Question: In one sentence, what is this figure communicating?
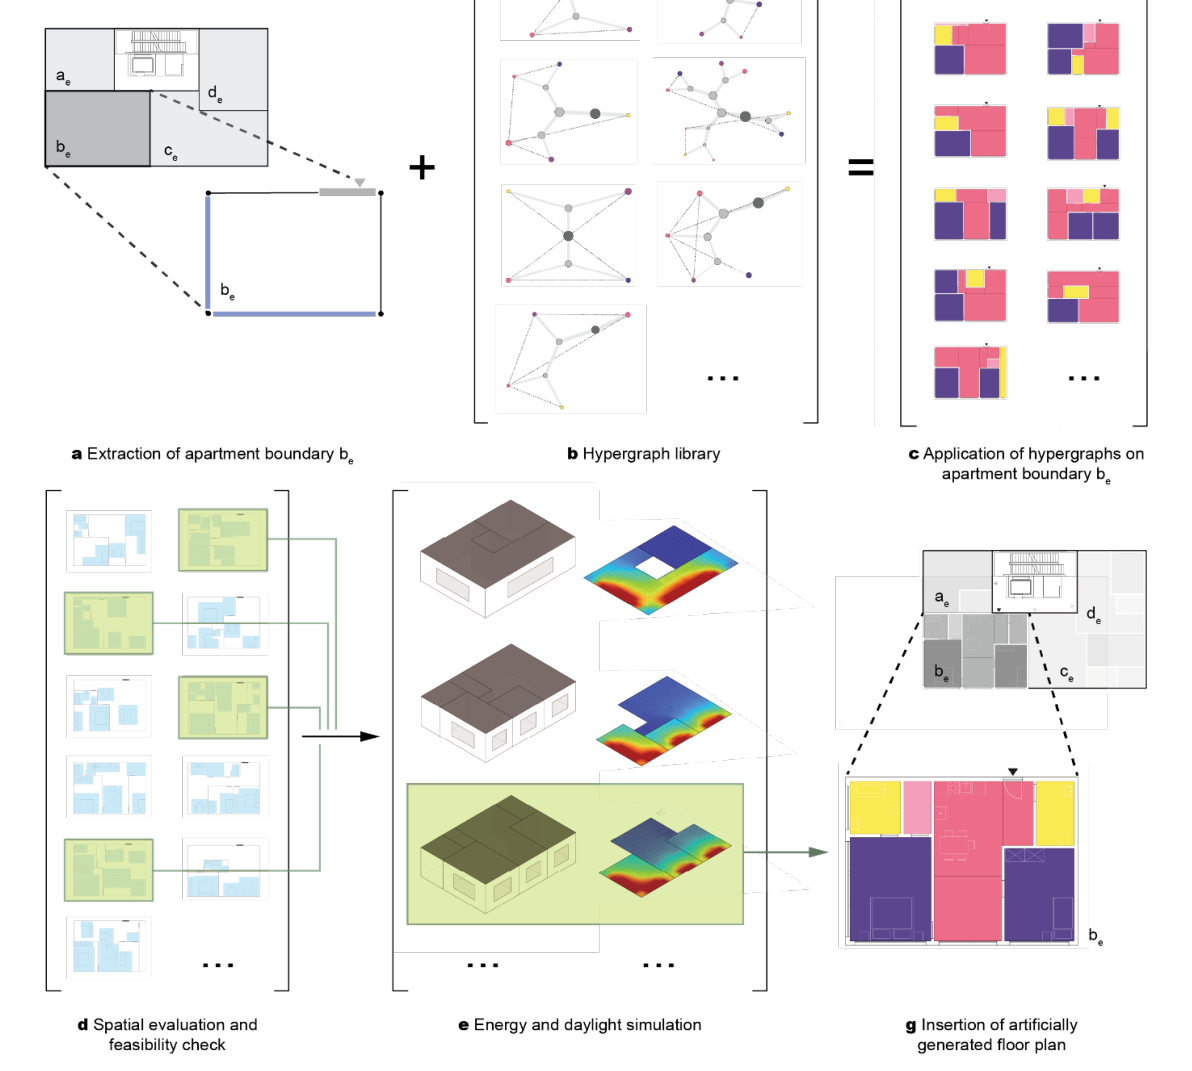
Answer: Steps for fitting an apartment using the hypergraph method. An apartment boundary is extracted from a building (a)  and combined with a library of hypergraphs (b). The applied hypergraphs generate different internal subdivisions for the  apartment boundary (c). A spatial evaluation using placement of furniture, accessibility and room geometry is performed to filter